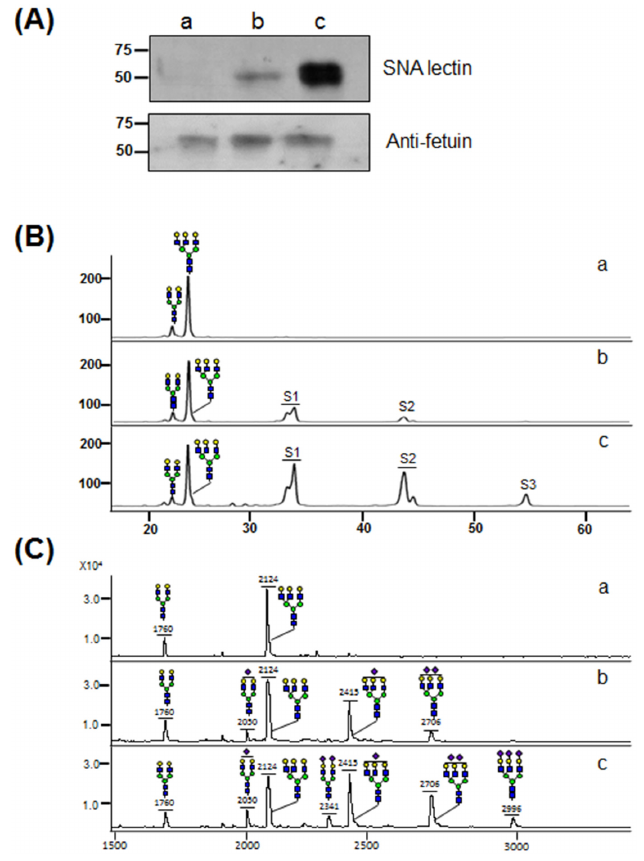
Fig 7. In vitro sialylation of asialofetuin by P145-ST. (A) Lectin blot assay was performed using SNA lectin for detection of α (2,6)-sialic acid of fetuin sialylated by P145-ST (upper panel). As a control experiment, immunoblot assay was also carried out using an anti-fetuin antibody (lower panel). N -glycans obtained from asialofetuins sialylated by P145-ST reaction were analyzed using HPLC (B) and MALDI-TOF (C). S1, S2, and S3 represent mono-, di-, and tri-sialylated glycans respectively. Symbols for glycans are the same as in Fig 2. Here, ‘ a ’ : asialofetuin as “ a ” : asialofetuin as a control without ST reaction, “ b ” : sialylated asialofetuin in the reaction condition without supplemental addition, “ c ” : sialylated asialofetuin in the optimized condition with the supplemental addition of CMP-NeuAc and